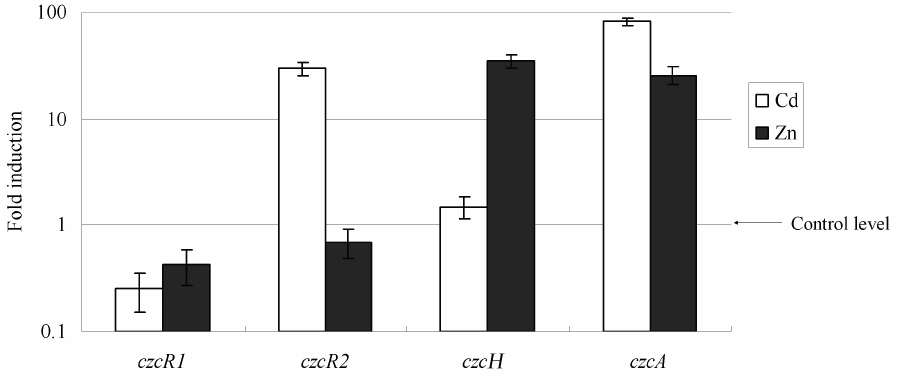
Figure 2. Transcription of czcR1 , czcR2 , czcH , and czcA genes analyzed by qRT-PCR in the wild-type X4 strain grown in the presence of 300 μ M Zn 2+ or Cd 2+ . The amount of mRNA is represented relative to the X4 strain cultivated in the absence of metal ions. Error bars represent the standard deviations of three determinations.